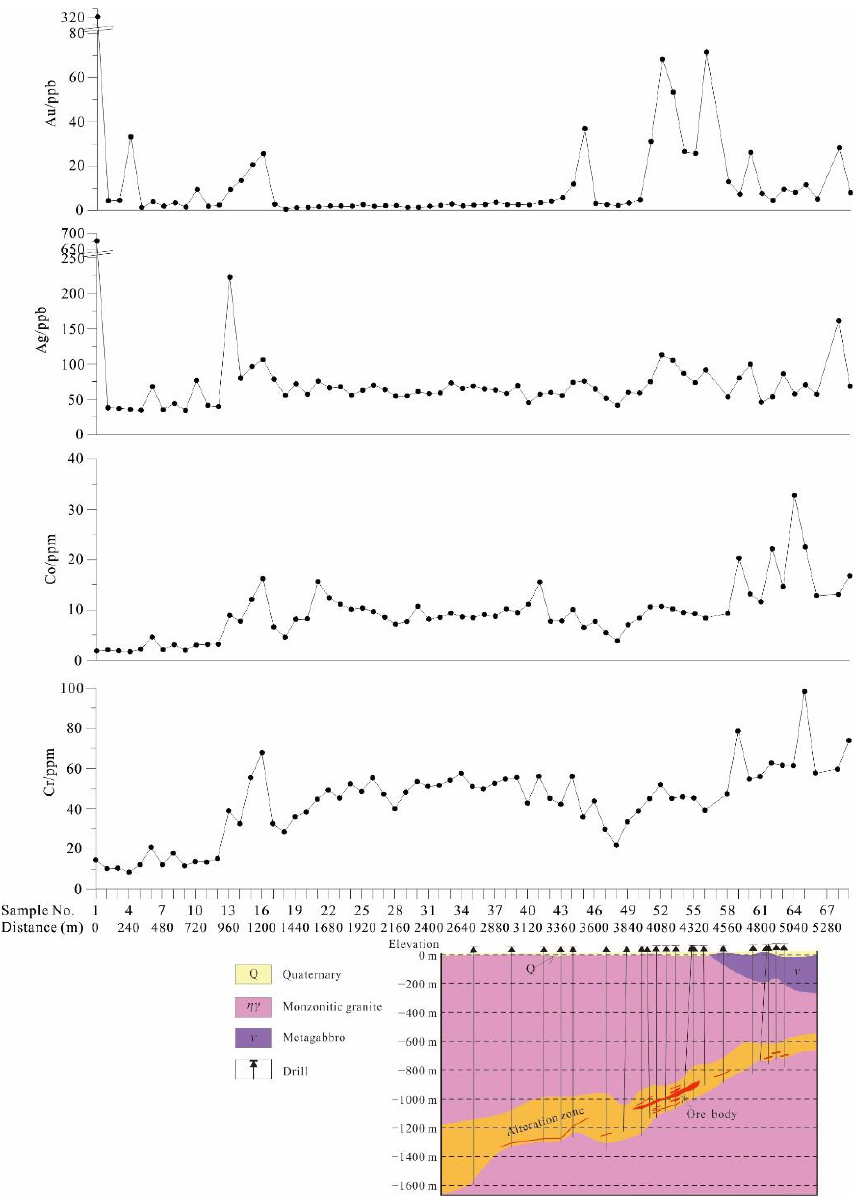
Figure 11. Au, Ag, Co, and Cr line chart of fine-fraction soil samples (<125 μm) across the concealed ore body in the Qujia deposit.